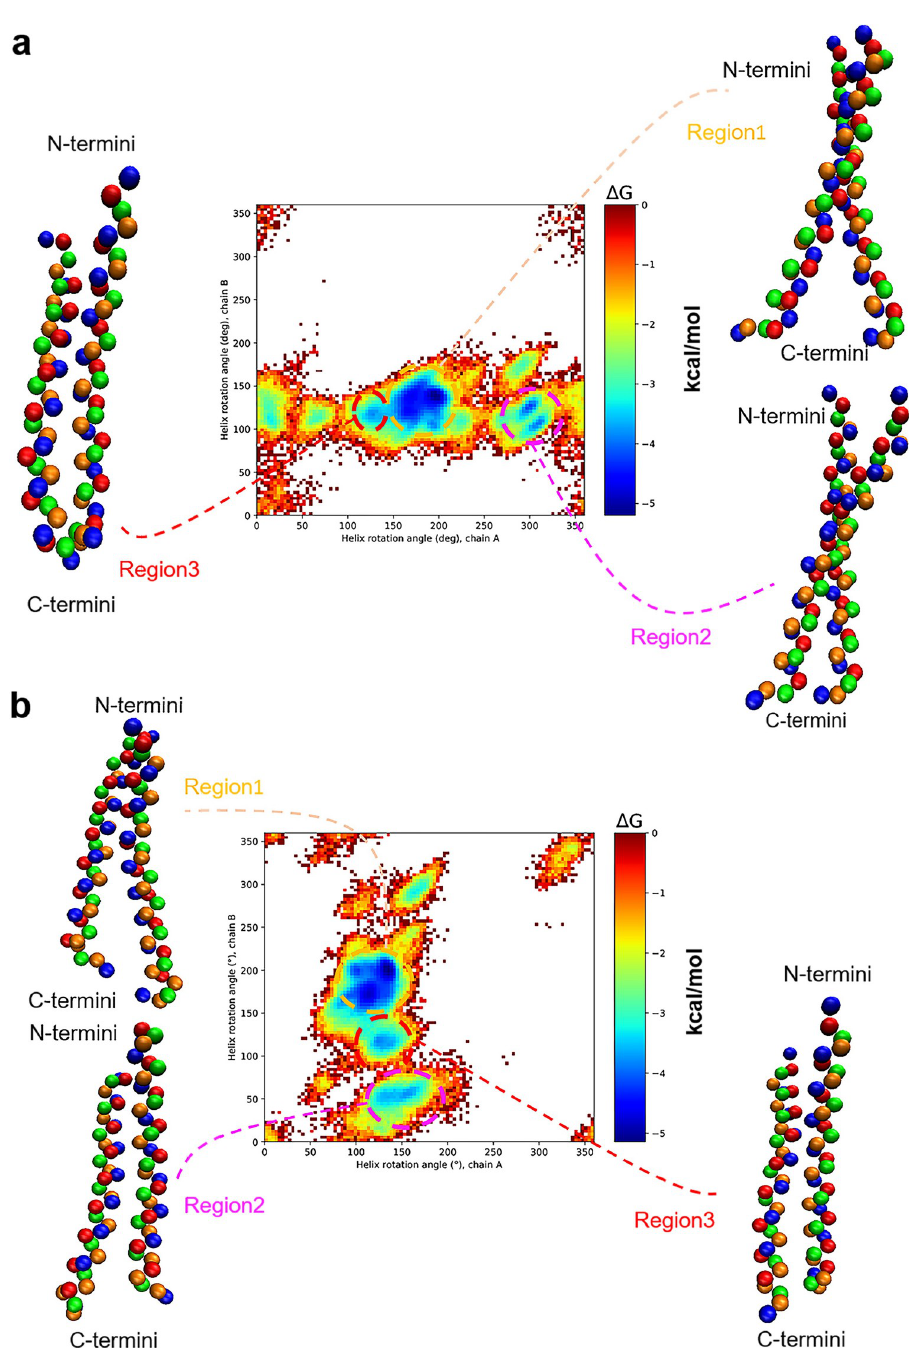
Fig 4. Free energy profiles and the representative simulated structures of the TM helix dimer. (a) The free energy profile and the simulated structures of the TM helix dimer from an arbitrarily chosen trajectory. Three basins appearing as free energy minima corresponding to inactive TMD structures are shown with dashed lines, together with their representative structures. TMD backbones are displayed with colored beads. (b) The same as in (a) but from another arbitrarily chosen